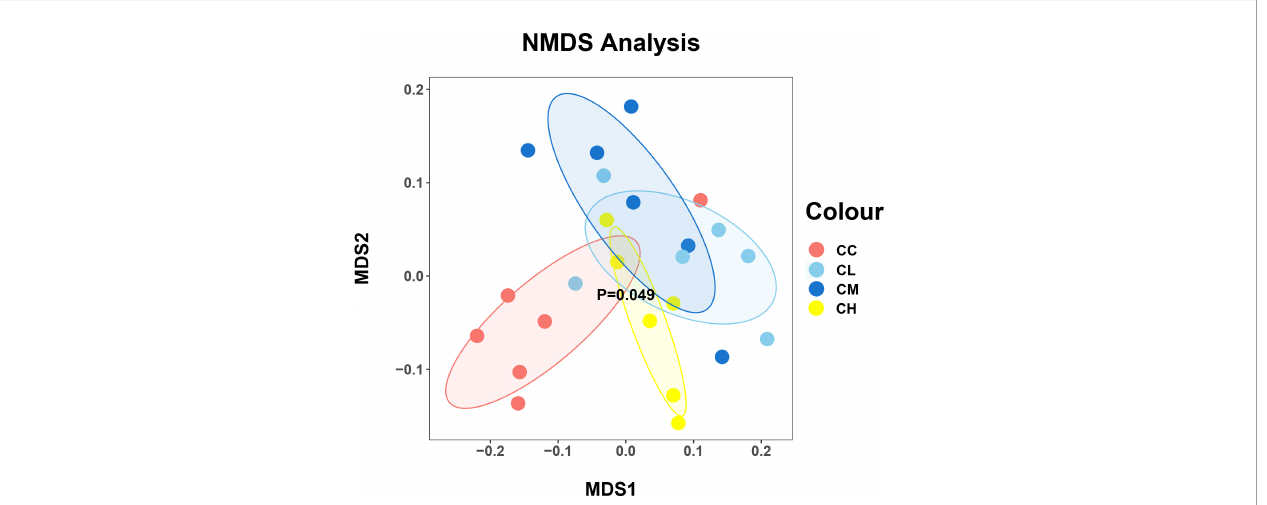
FIGURE 6 The beta diversity of mice intestinal mucosal bacteria. Each point represents a sample, and samples of different groups are represented by different colors. The closer the distance between two points is, the higher the similarity is between two samples, and the smaller the difference is. CC: control